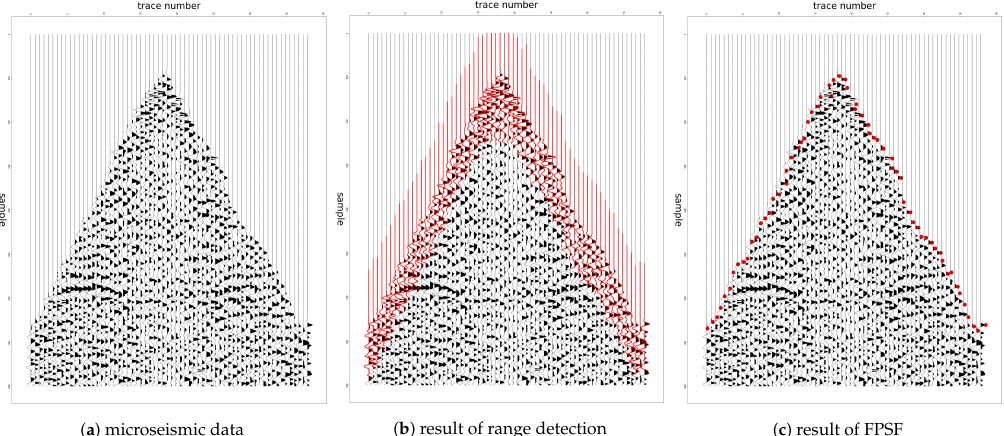
Figure 4. First arrivals picked by FPSF for field microseismic record. ( a ) field microseismic record; ( b ) the result of range detection; ( c ) the result of FPSF.